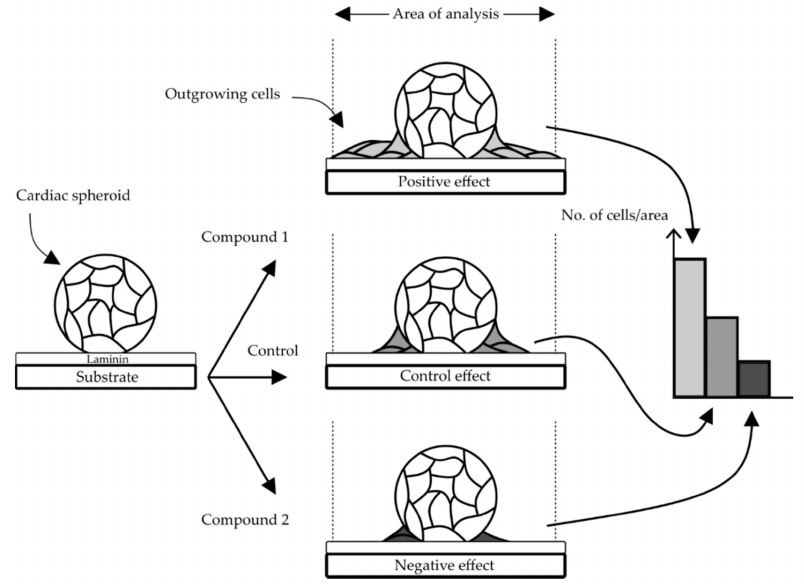
Figure 2. Concept of the proposed cardiac cell outgrowth assay. An outgrowth of cells from spheroids over time was observed on laminin coated surfaces (control) and the number of cells within a defined area should be possible to quantify and potentially reveal an increased (positive) or decreased (negative) effect depending on the